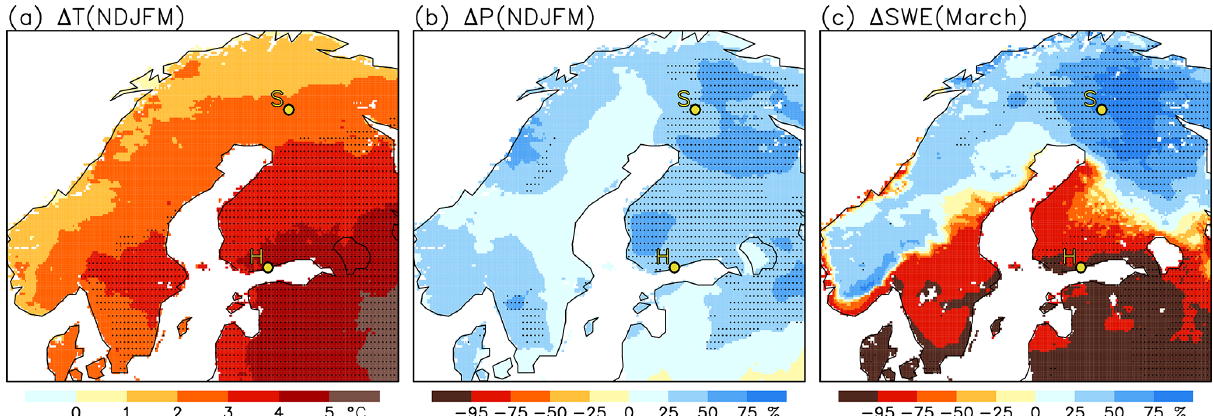
Figure 1. Anomalies of mean temperature (a) and precipitation (b) in November–March 2019/20 and the anomaly in SWE in March 2020 (c) compared with the corresponding mean values in the 39-winter period 1981/82–2019/20, based on ERA5-Land. Stippling indicates areas where the values in 2019/20 were either above or below the range in the previous 38 winters. The locations of Helsinki (H) and Sodankylä (S) are shown with yellow circles.